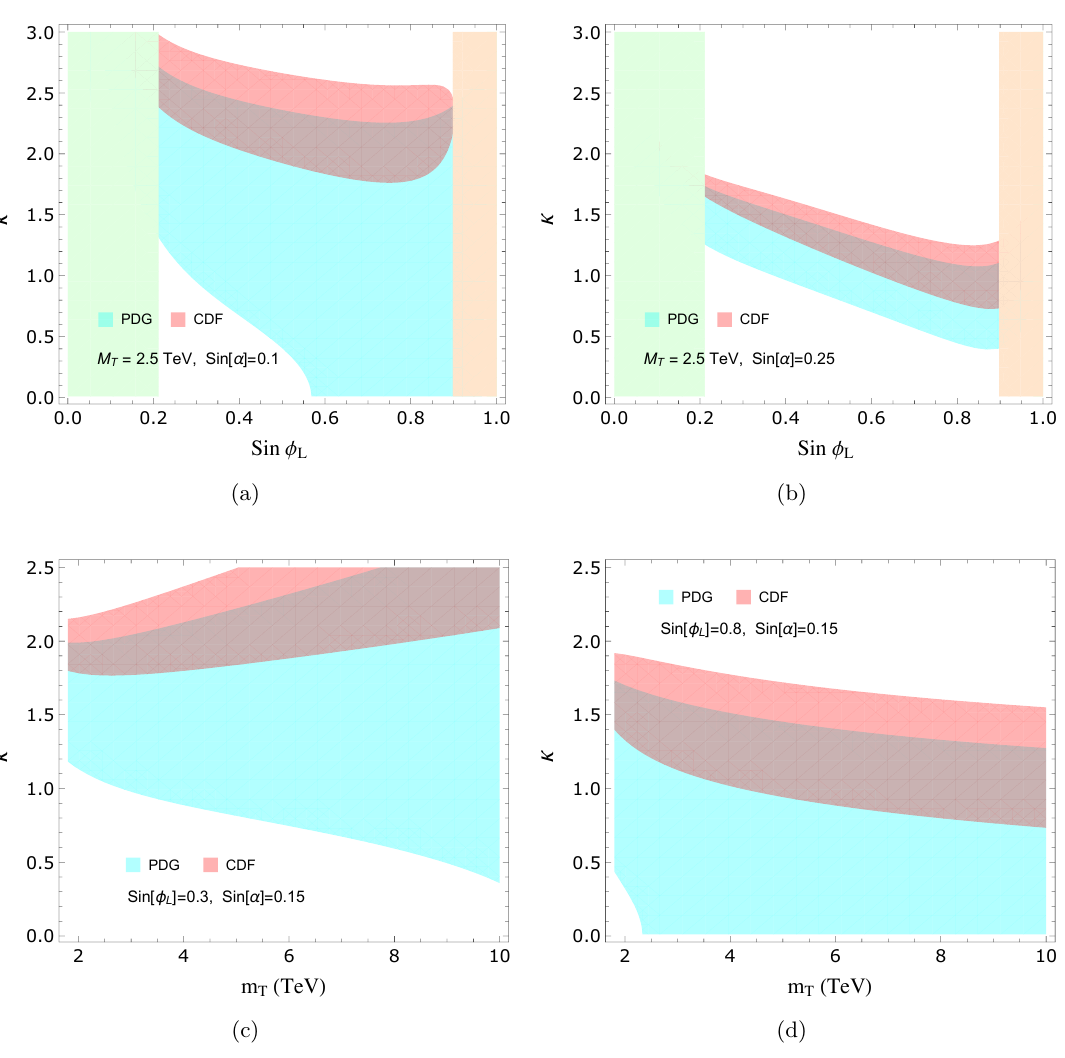
Figure 2 . The regions satisfied the precision measurements at 99% C.L. for the bi-doublet scenario with ∆ M = 0 . 1 TeV. The green and yellow bands are the same as figure 1, and the off-perturbation condition is sin 2 φ L < 6 m t m T